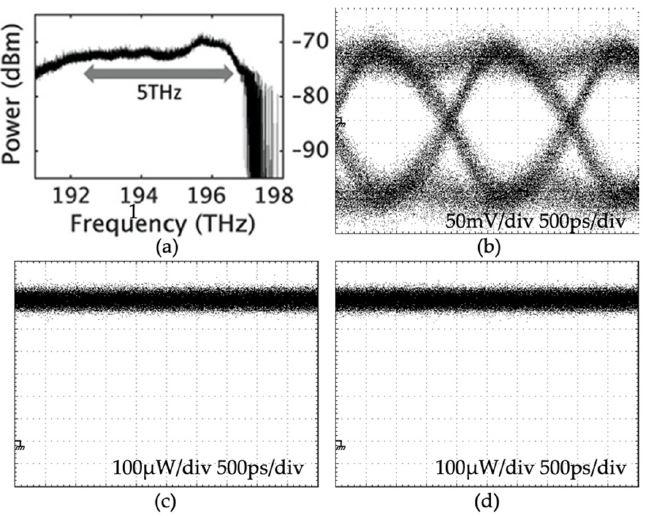
Figure 6. Experimental results of optical stealth communication: ( a ) spectrum of the stealth signal hidden in noise; ( b ) recovered stealth signal; ( c ) stealth signal hidden in noise without matching condition; ( d ) pure noise without stealth signal.